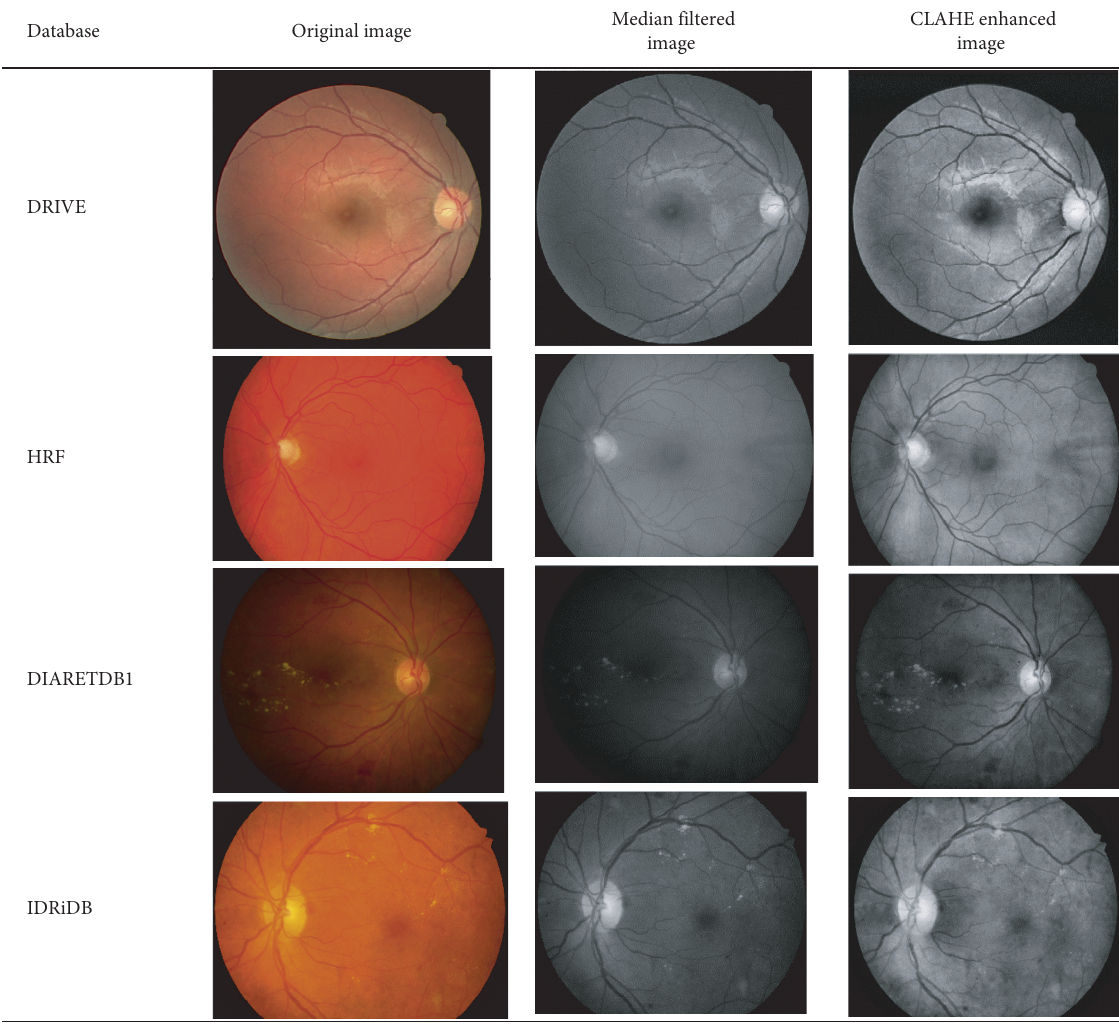
Figure 2: Preprocessed retinal images using the median filter and